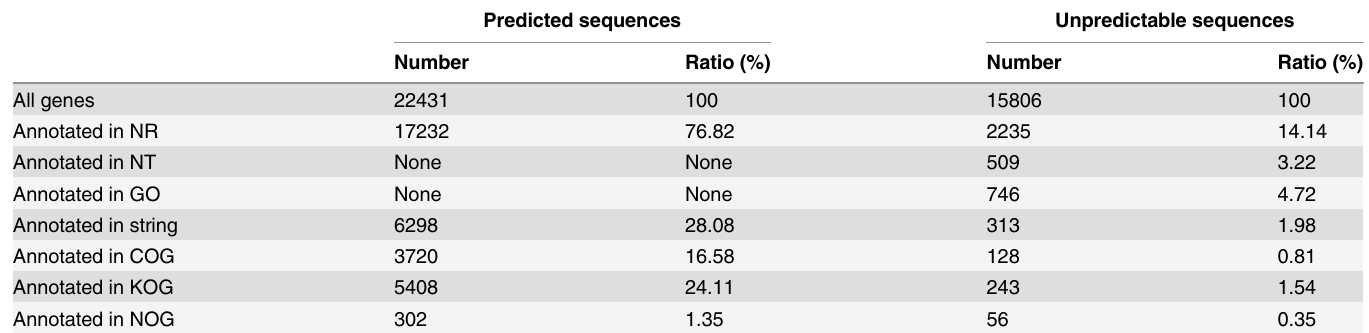
Table 3. Summary of the annotations of Litopenaeus vannamei